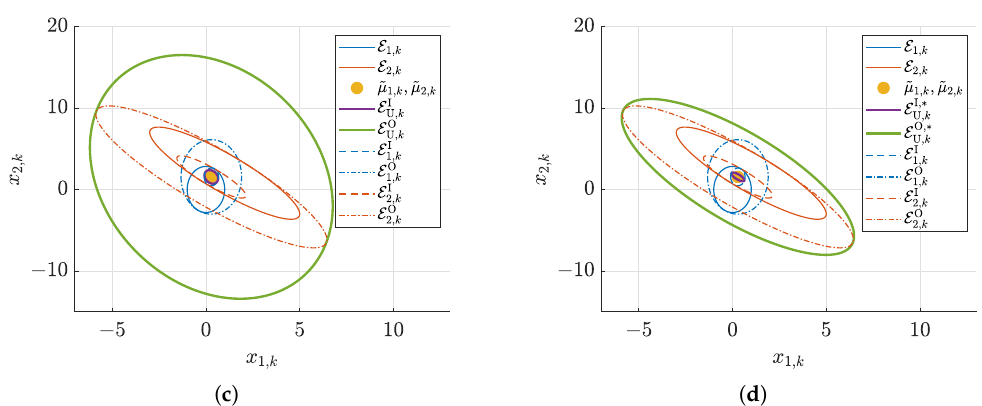
Figure 5. Union of ellipsoids E 1, k and E 2, k with identical and different midpoints. Inner bound of the resulting thick ellipsoid: E I ; outer bound: E O ( ∗ symbols denote the solution enclosure according U, k U, k to Equation (65)). ( a ) Union of ellipsoids with identical midpoints, cf. (55). ( b ) Union of ellipsoids with the initial ellipsoid parameterization (55), (56), enclosure definition (65). ( c ) Union of ellipsoids with the initial ellipsoid parameterization (56), (57), enclosure definition (60). ( d ) Union of ellipsoids with the initial ellipsoid parameterization (56), (57), enclosure definition (65).